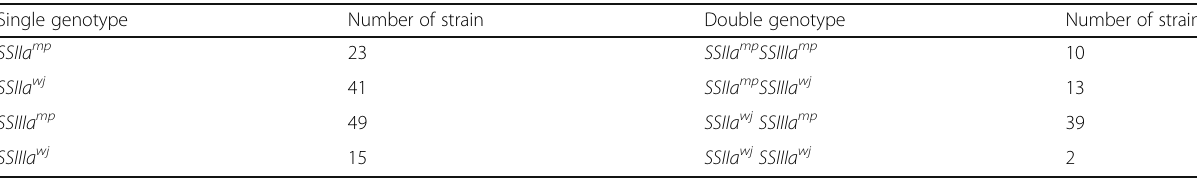
Table 2 The genotypes of SSIIa and SSIIIa locus for 64 semi waxy lines derived from Wujing 13/ Milky Princess with Wx mp gene Single